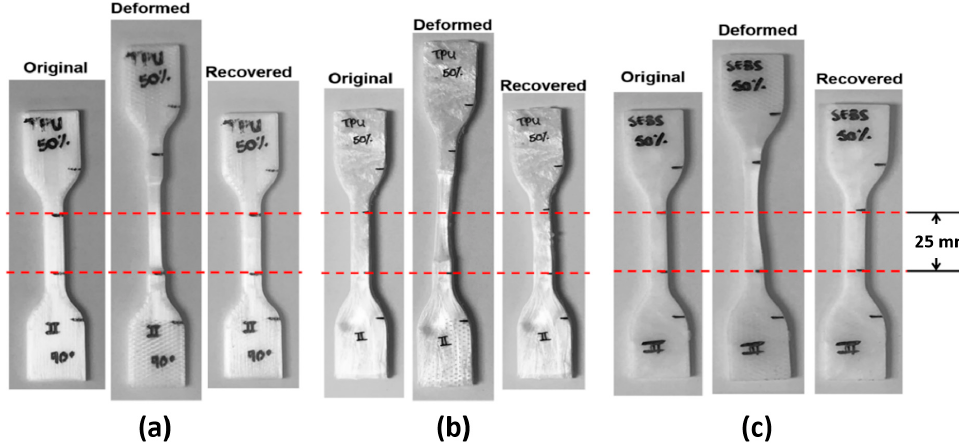
Figure 14. Examples of the process used to determine shape memory properties for ( a ) PLA:TPU 50:50 FFF-manufactured in a longitudinal raster pattern, ( b ) PLA:TPU 50:50 injection molded, and ( c ) PLA:SEBS 50:50 injection molded.